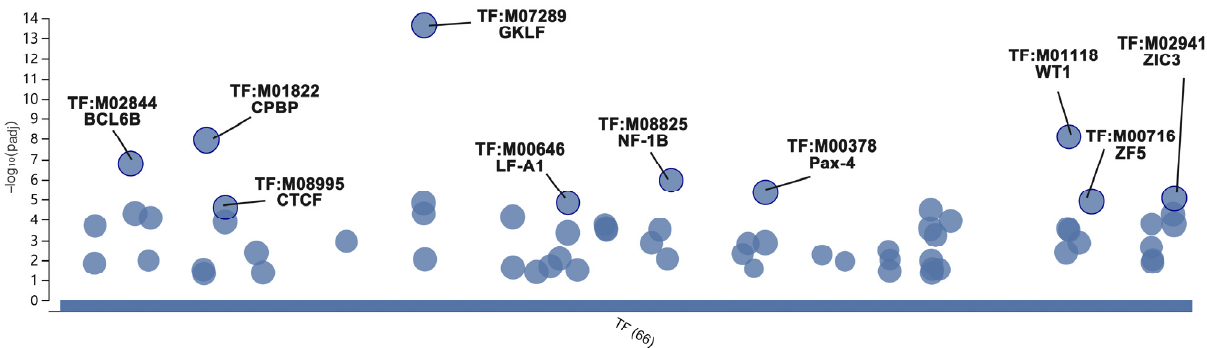
Figure 9. Bubble plot of prediction of key TFs. In the vertical direction, the higher the bubble, the more significantly enriched. In the horizontal direction, TFs within the same subtree stay close to each other. Table 3. Node, edge, and score of the top 5 sub-clusters.